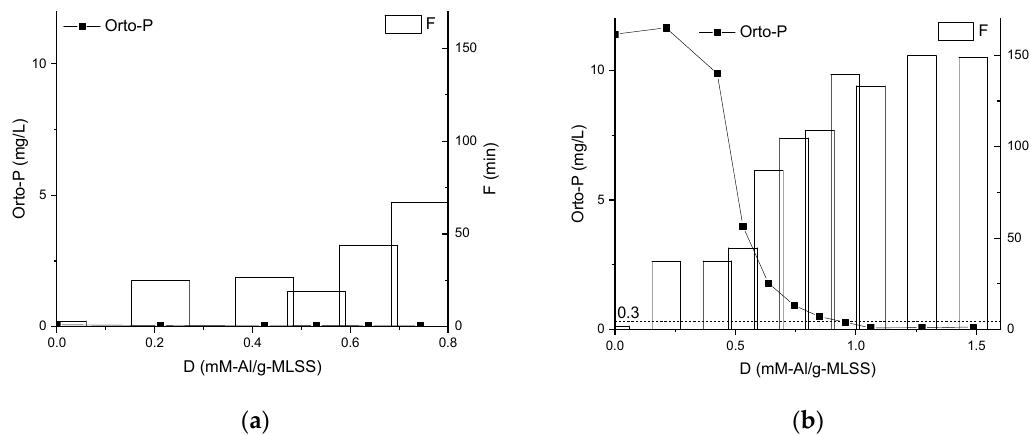
Figure 7. Influence of chemical enhancer dose on the concentration of orthophosphates in filtrate and filtration duration of Mixed Liquors from MBBR ( a ) and IFAS ( b ).